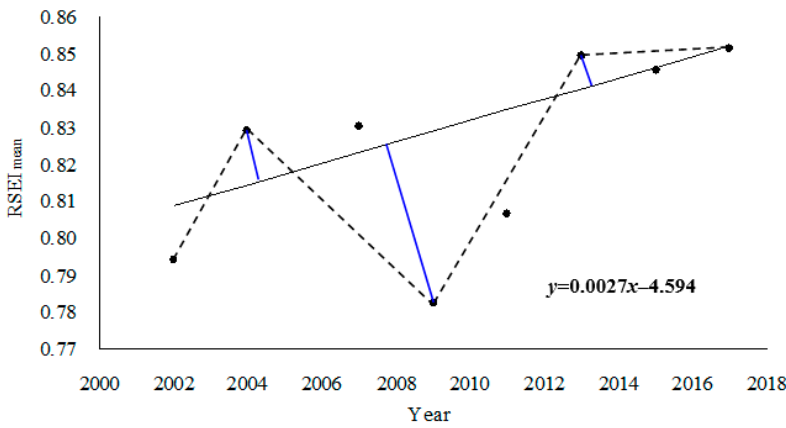
Figure 7. Temporal segmentation to detect ecological improvement and decline durations for the study period.